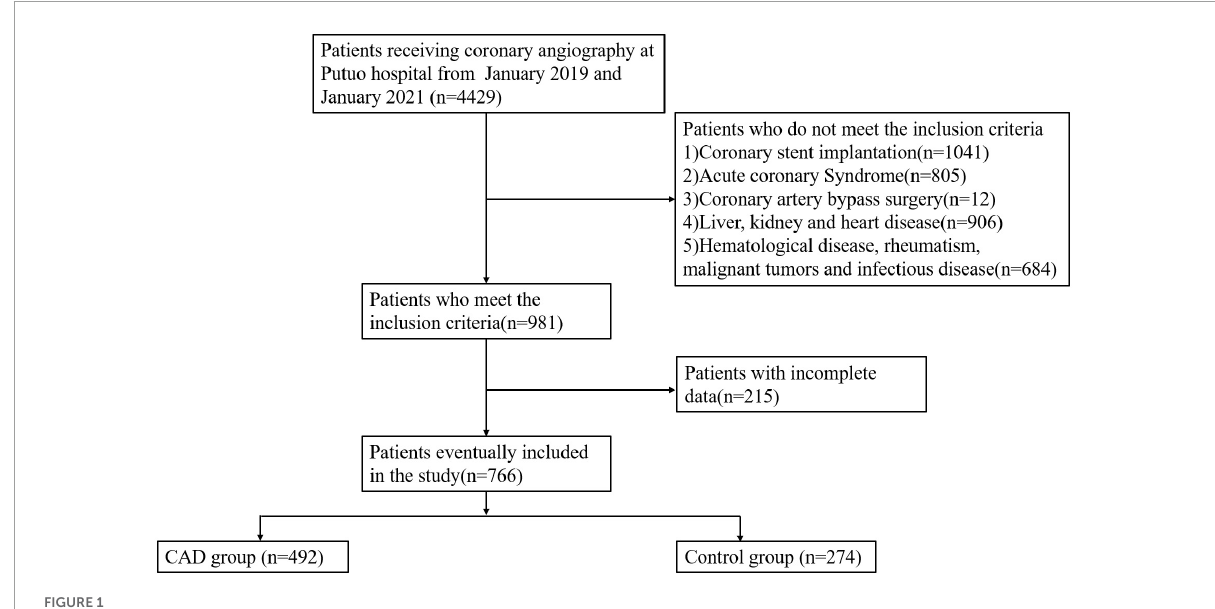
FIGURE1 Flow chart of the research process.